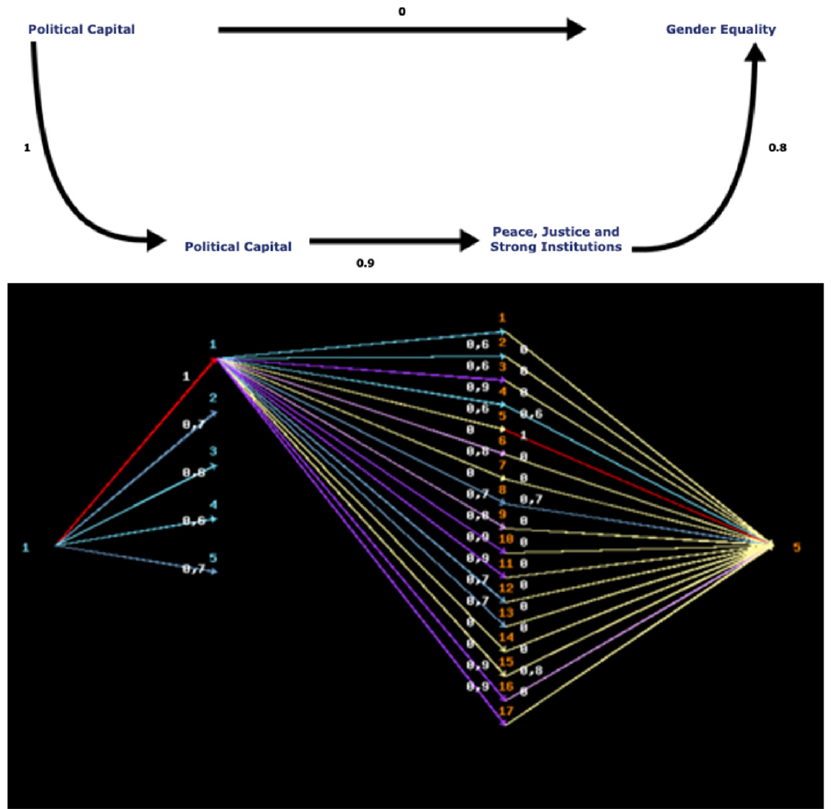
Figure 10. Relation between Political Capital (H1) and Gender Equality (SDG5).